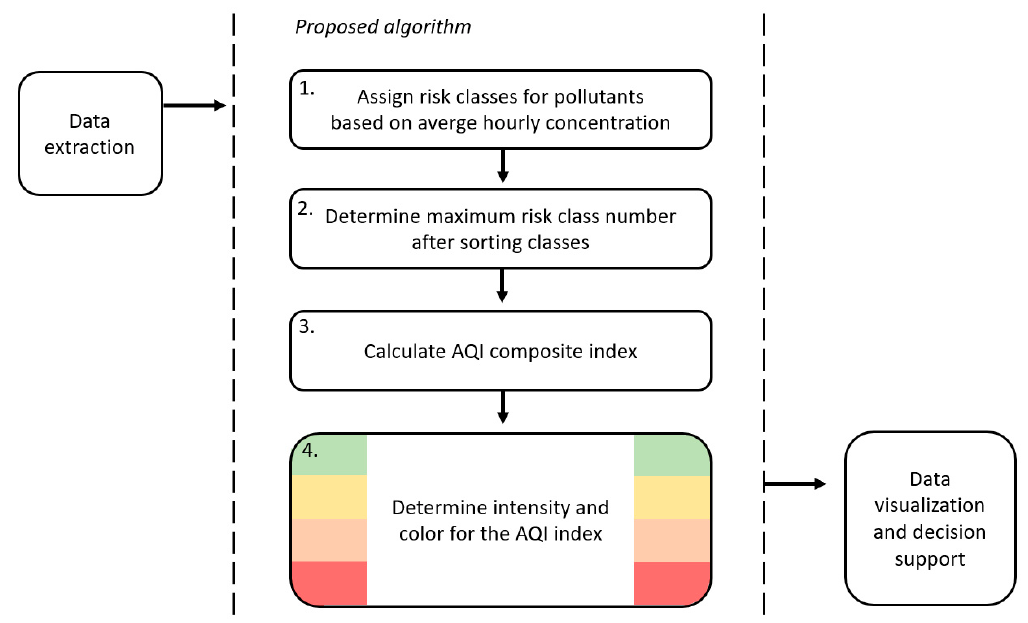
Figure 2. Flowchart for the decision support algorithm .